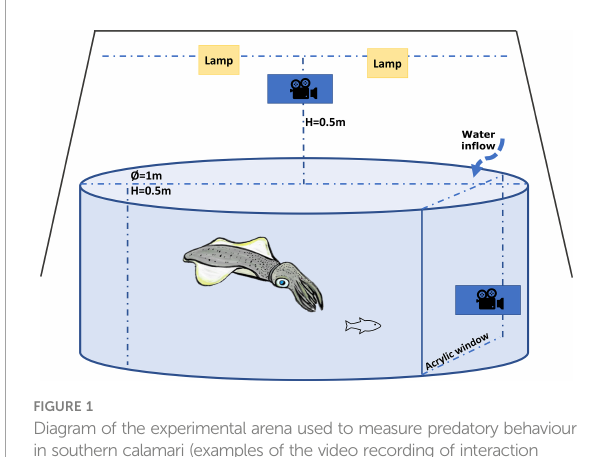
FIGURE 1 Diagram of the experimental arena used to measure predatory